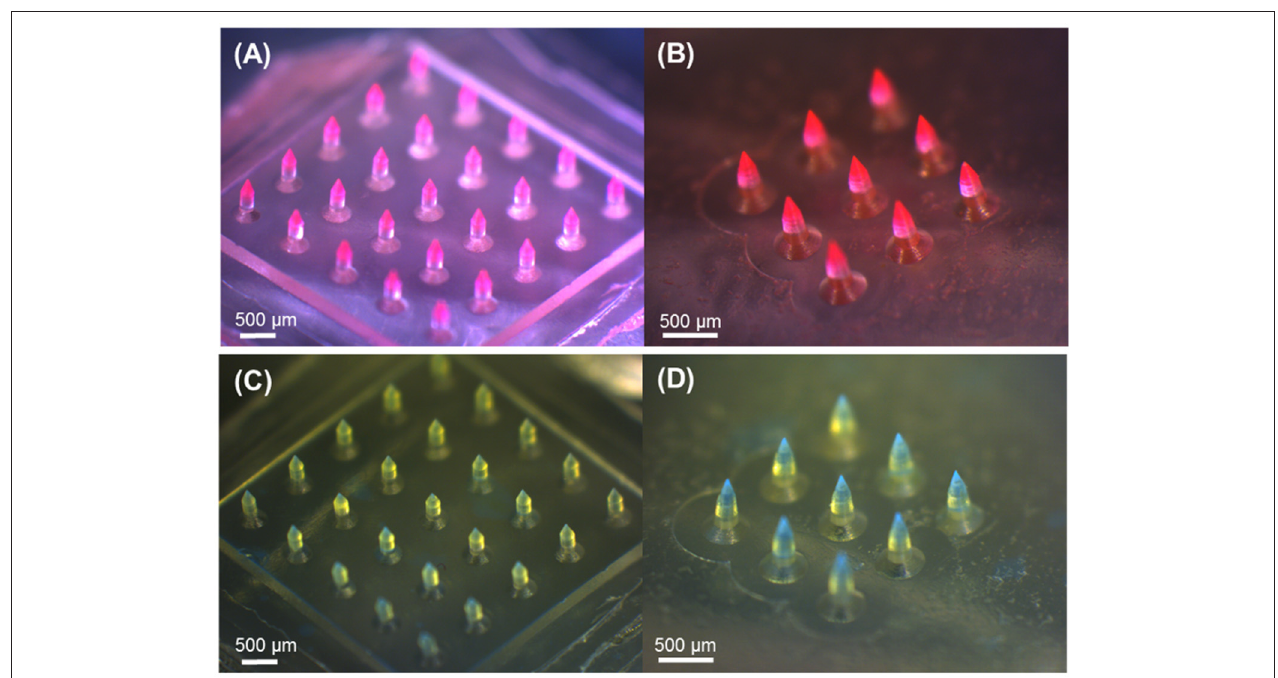
FIGURE 4 | Optical microscopy images of obelisk-type polymer microneedles fabricated by the spray deposition process. PVP and PLGA layers contain SRB (red) and coumarin 314 (blue), respectively, for visualization. (A) PVP circular obelisk microneedle array. (B) PVP beveled-circular obelisk microneedle array. (C) PLGA circular obelisk microneedle array. (D) PLGA beveled-circular obelisk microneedle array. Scale bars represent 500 µ m.